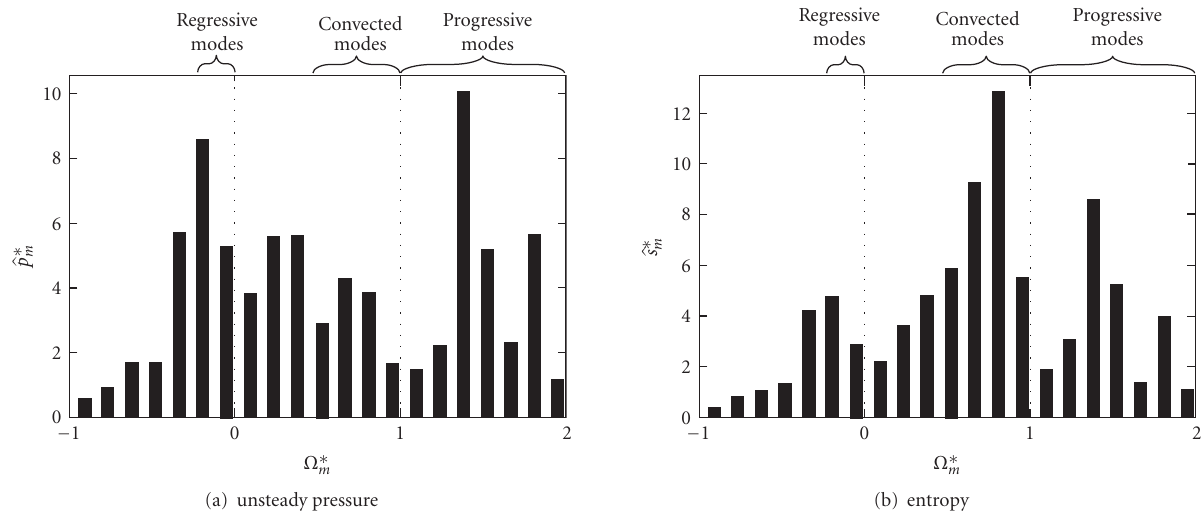
Figure 8: Reduced amplitudes of the spinning modes at mid inter row gap and 50% section